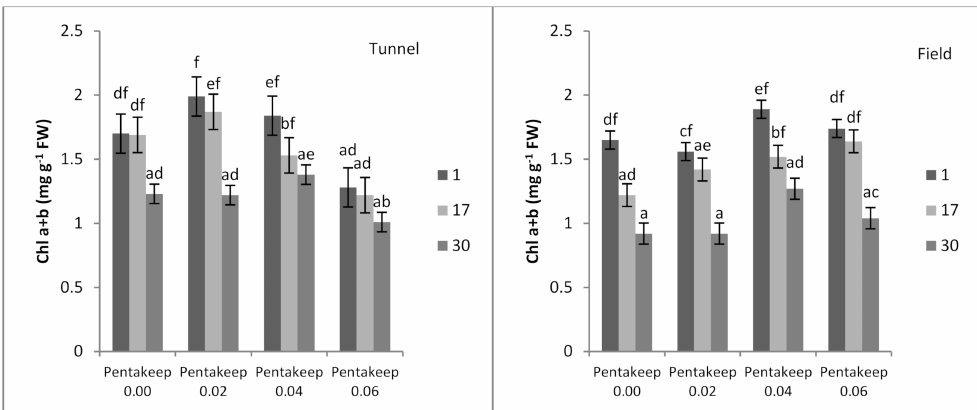
Figure 3. E ff ect of growth conditions (unheated foil tunnel and open field) and foliar treatment (six times during vegetative period) with di ff erent concentrations of Pentakeep V (0.00%, 0.02%, 0.04%, 0.06%) on the content of chlorophyll a + b in leaves measured after 1, 17, and 30 days of storage of the P. multiflorum cut foliage in water. Values are mean ± SE, n = 5. The bars marked with the same letters are not significantly di ff erent at p <